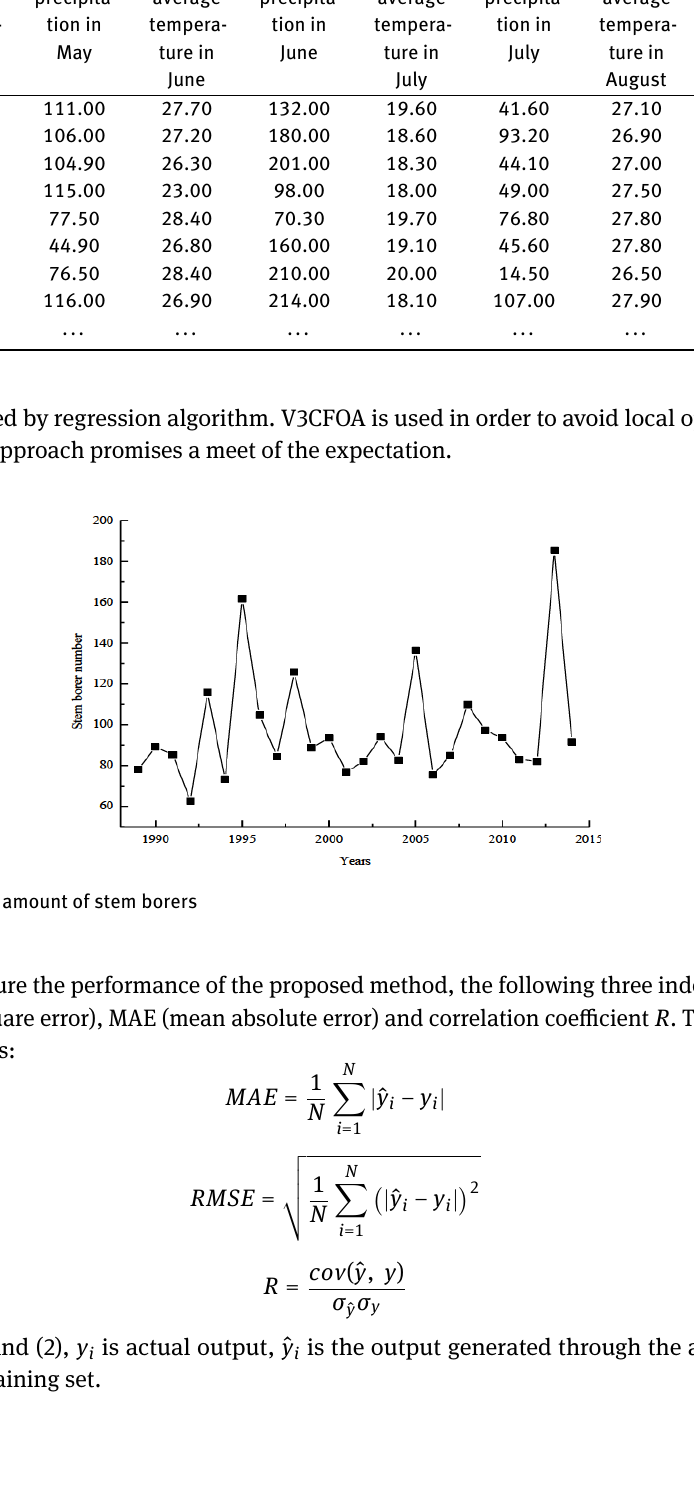
Table 1: Part of the training data sample Attributes